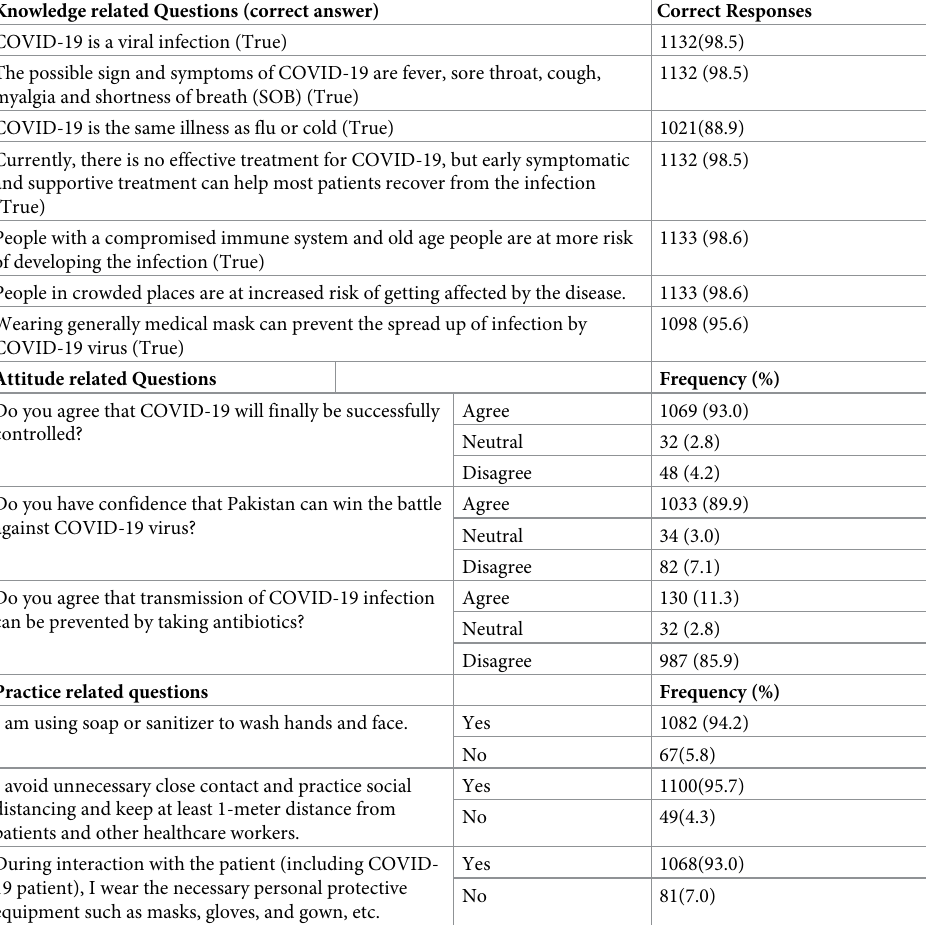
Table 4. Knowledge, attitude and practices responses of pharmacist regarding